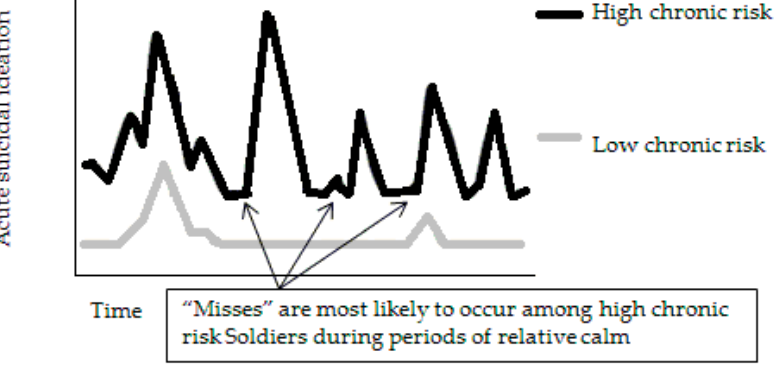
Figure 1. Variability in risk for suicide over time in high and low chronic risk individuals.